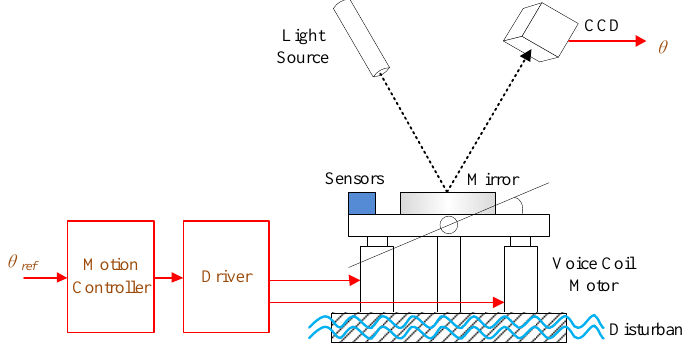
Figure 1. The structure of the fast steering mirror (FSM) control system.